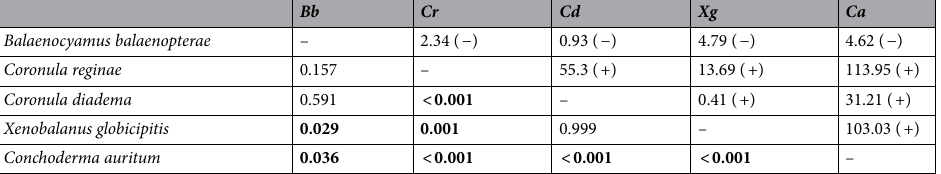
Table 3. Pairwise chi-square tests for co-occurrence of the epibiotic fauna found on Antarctic minke whales, Balaenoptera bonaerensis , in the Southern Ocean. The values of the χ 2 statistic, and associated exact probability (with significant values marked in bold), are shown in the upper and lower triangular matrices, respectively. Column headings correspond to epibiotic species’ names; (+) and (−) stand for positive and negative association,